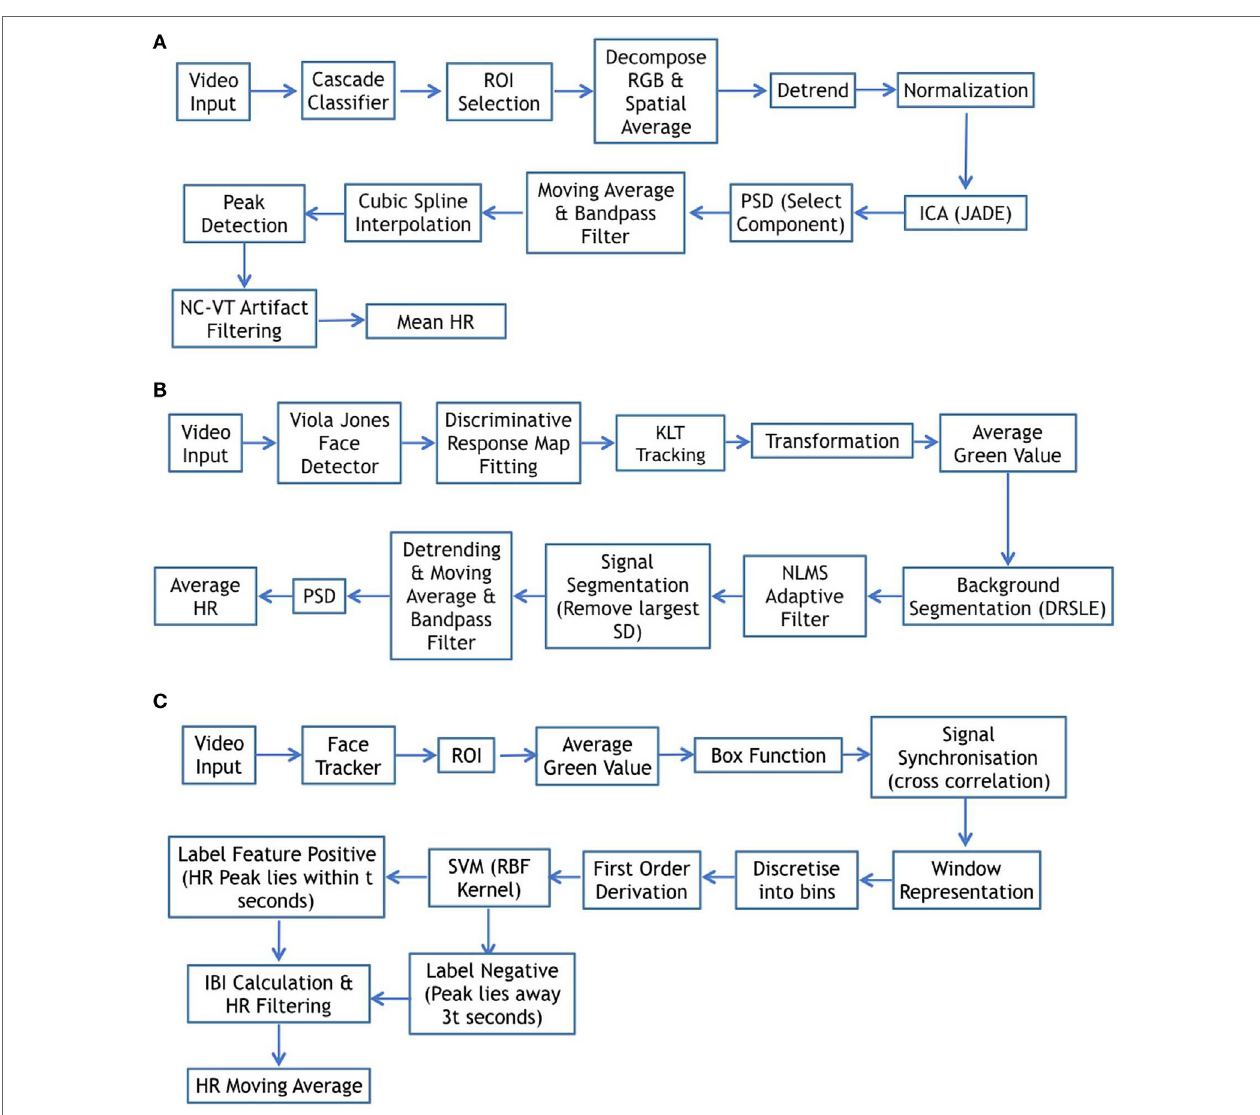
FigURe 6 | Schematic diagram for complete method comparison. (a) Schematic diagram from Poh et al. (2011). (b) Schematic diagram from Li et al. (2014). (c) Schematic diagram from Osman et al.